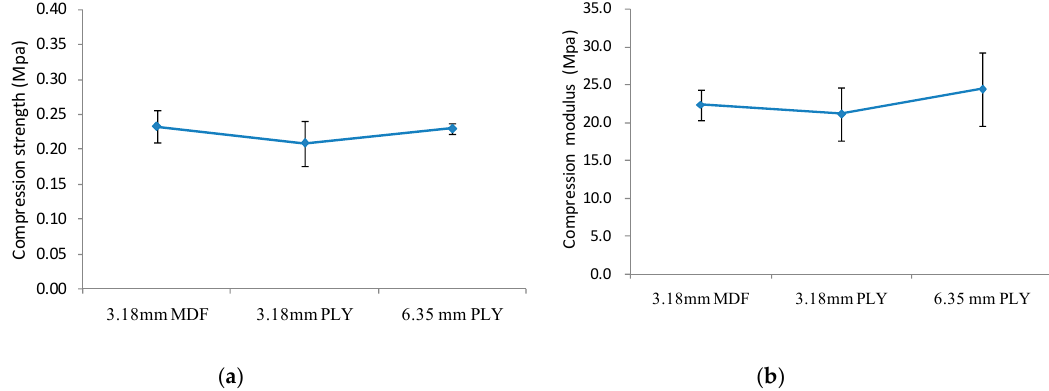
Figure 7. The effect of surface sheets on compression properties: ( a ) compression strength; ( b ) compression modulus (ore thickness:25.4mm;loading speed: 0.5mm/min; and vertical bar: error bar Figure 7. The e ff ect of surface sheets on compression properties: ( a ) compression strength; with standard deviation). ( b ) compression modulus (ore thickness: 25.4 mm; loading speed: 0.5 mm / min; and vertical bar: error bar with standard deviation).